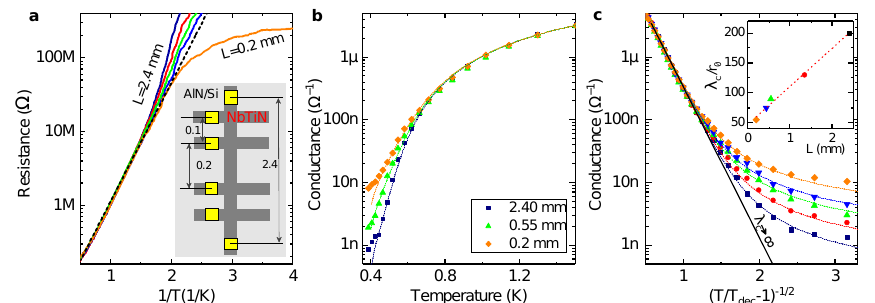
Figure 5. Sheet resistance of a NbTiN superinsulating film as a function of the effective sample size (bridge length) ( a ) Logarithmic plot of sheet resistance R (cid:3) vs. inverse temperature 1/ T for bridges of various length L . The dashed straight line shows the Arrhenius behaviour R ∝ exp ( 1/ T ) . Inset: experimental setup. The Si substrate with AlN buffer layer is shown with light gray and the Hall bridge of NbTiN is dark grey. The square gold contacts are given in yellow. All lateral sizes are given in millimetres. ( b ) Same data as in ( a ) but replotted in terms of the conductance G = 1/ R (cid:3) vs. T in log-line scale. The dotted lines are fits using a two dimensional Coulomb gas model that generalises the Berezinskii-Kosterlitz-Thouless (BKT) formula for the conductance G ∝ exp [ − ( T / T dec − 1 ) 1/2 ] by incorporating a self-consistent solution of the effects of electrostatic screening, where the screening length λ c and T dec enter as fitting parameters. For all bridges the deconfinement temperature is T dec ≈ 400mK. ( c ) Same data as in ( b ) but for temperature renormalized as ( T / T dec − 1 ) 1/2 . The solid line corresponds to the case of an infinite electrostatic screening length λ c → ∞